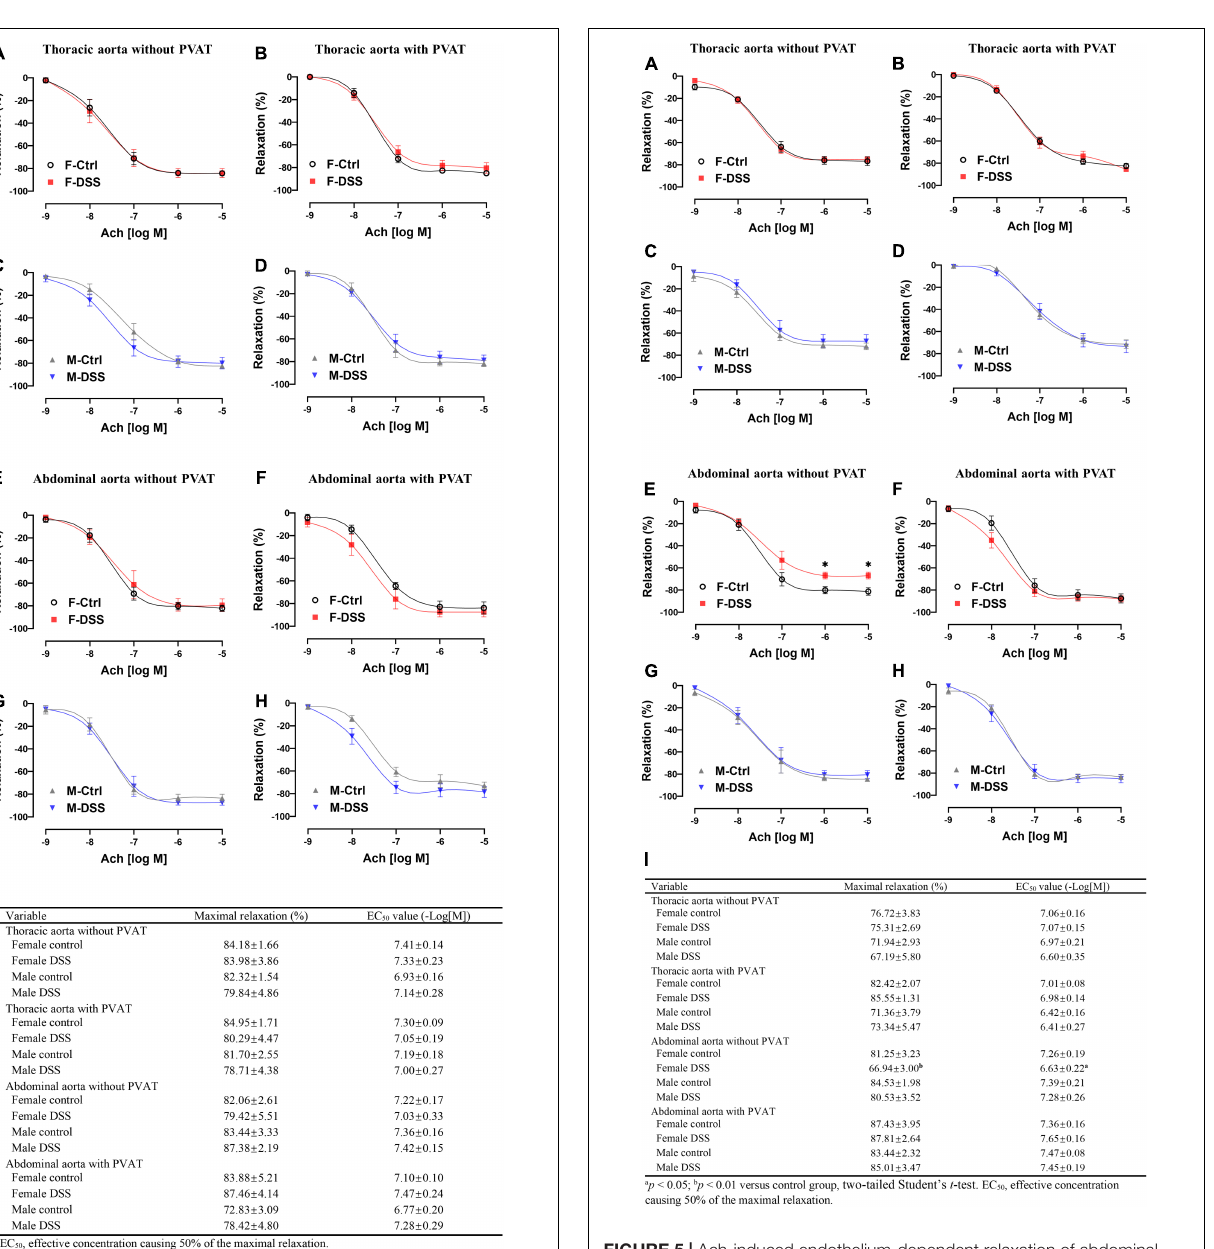
FIGURE 4 | Aortic endothelial function was preserved in both male and female mice with DSS-induced acute colitis. (A–D) Ach-induced endothelium-dependent relaxation of thoracic aorta with or without PVAT. (E–H) Ach-induced endothelium-dependent relaxation of abdominal aorta with or without PVAT. (I) Maximal relaxation and EC 50 for Ach were calculated in the table. Results are expressed as means ± SEM. * p < 0.05, in two-way ANOVA followed by Bonferroni correction (A–H) , n = 5–8 mice in each group. PVAT, perivascular adipose tissue; F and M, female and male mice, respectively. Ach, acetylcholine.